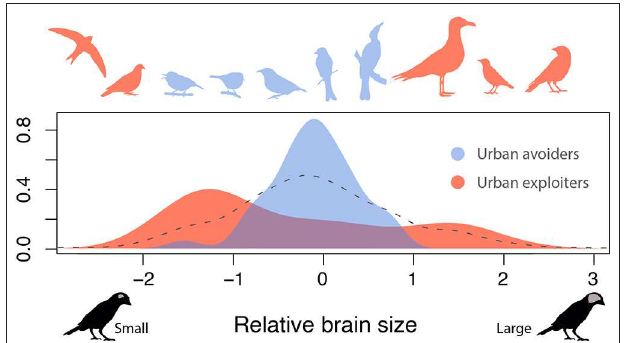
FIGURE 4 | Relative brain size distribution among urban exploiters and avoiders. Shown is the distribution of relative brain size across species from the ten families with the highest (urban exploiters) and ten families with lowest (urban avoiders) urban tolerance (see Supplementary Figure 2 for results with additional families). Silhouettes provide examples of some of the families, ordered by brain size, from left to right: Apodidae, Columbidaee, Zosteropidae, Reguliidae, Coerebidae, Dicruridae, Meliphagidae, Laridae, Passeridae, Corvidae (available at phylopic.org under a public domain license). Gray dashed line shows the distribution of relative brain size for all the species contained in the